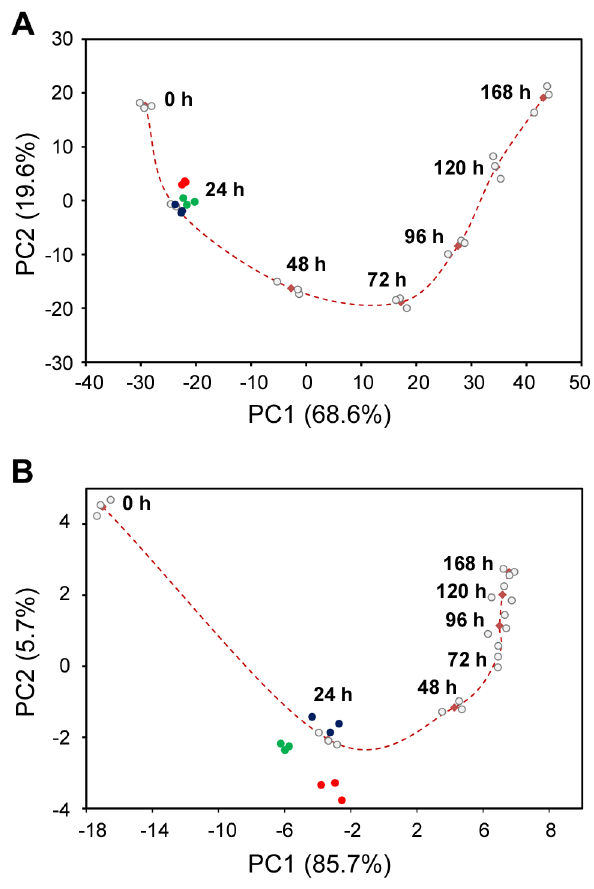
Figure 8. ESC differentiation track shown on two-dimensional PCA plot. The PCA was based ( A ) on the 1996 DEGs, or ( B ) on the 96 DEGs (see text for details on these two gene sets). The control samples at various time points of differentiation are shown as grey dots, and cultures exposed to thalidomide (THD), monobutyl phthalate (MBP), and valproic acid (VPA) for 24 h as blue, green and red dots respectively. The centers for the controls at each time point, defined by their mean values, are shown as dark red squares and the differentiation track is shown as the dashed line connecting the squares.